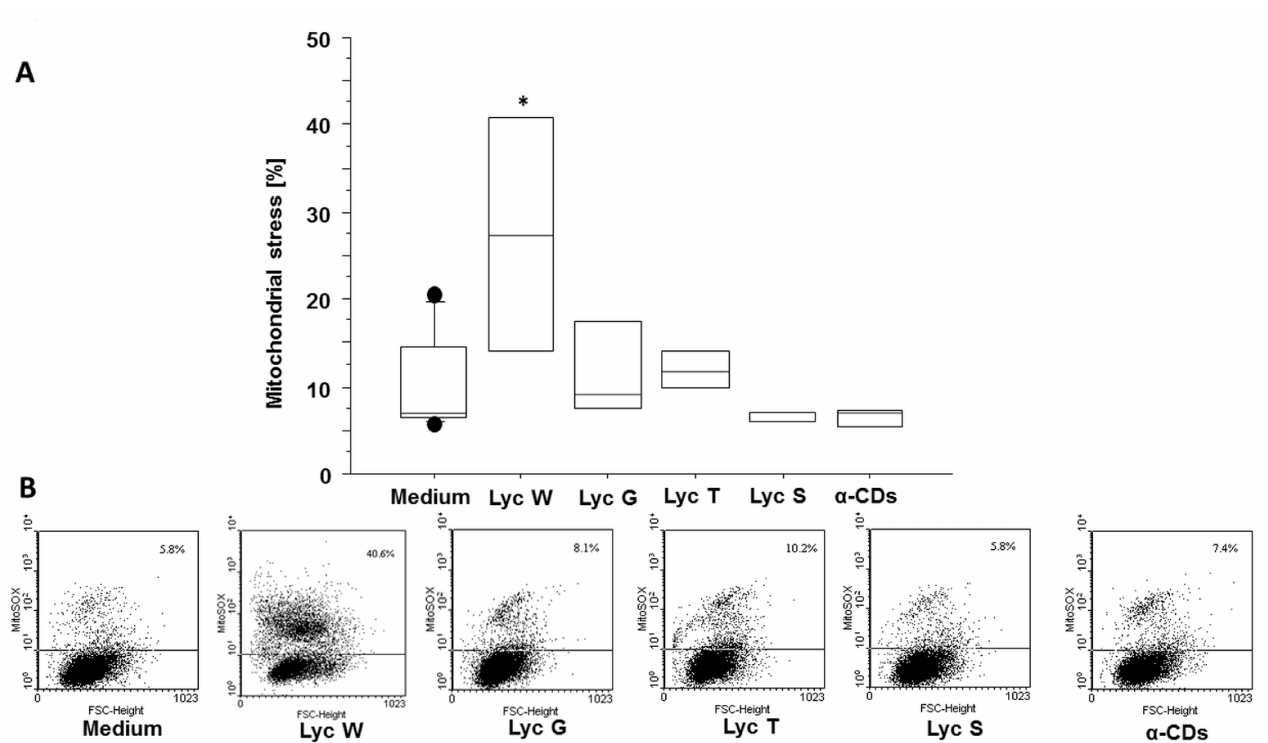
Figure 4. Lyc W effect on mitochondrial stress. ( A ) Lyc W significantly increased mitochondrial stress when compared to cells grown in medium or in Lyc G, Lyc T and Lyc S or in its carrier α -CDs. The results are shown as box-plots with medians (lines inside the boxes). Analysis of variance (ANOVA), Fisher’s PLSD, n = five experiments; *, p -value < 0.05. ( B ) representative examples of flow cytometric analysis for percentage of positive cells. The numbers indicate the percentage of positive cells for